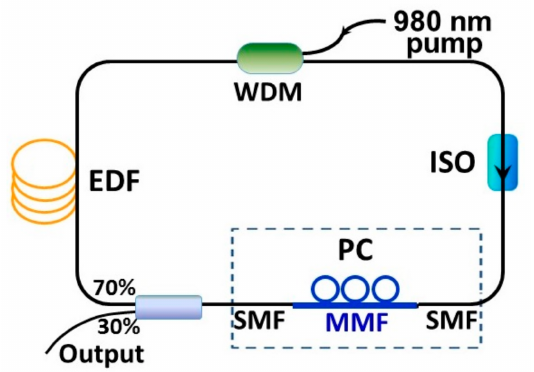
Figure 1. Experimental setup of the tunable and switchable erbium-doped fiber laser (EDFL). EDF: Erbium-doped fiber; WDM: Wavelength division multiplexer; ISO: Isolator; PC: Polarization controller; SMF: Single mode fiber; MMF: Multimode